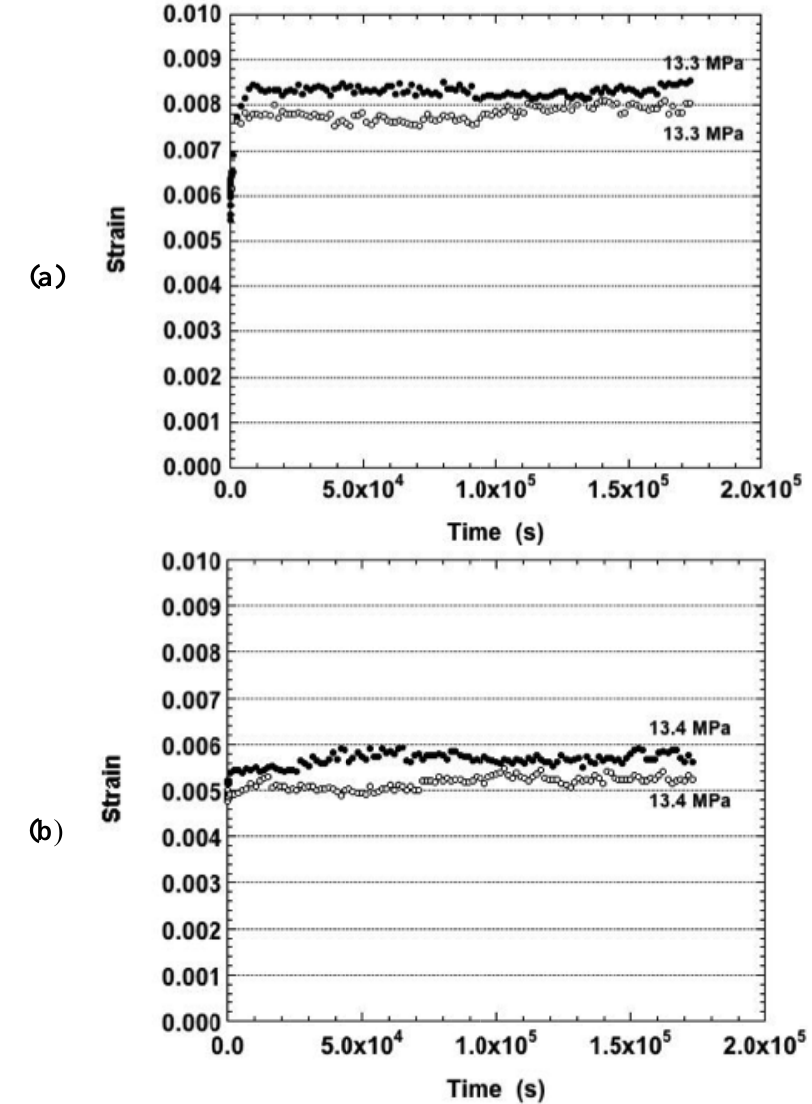
e 6. The du nal stress